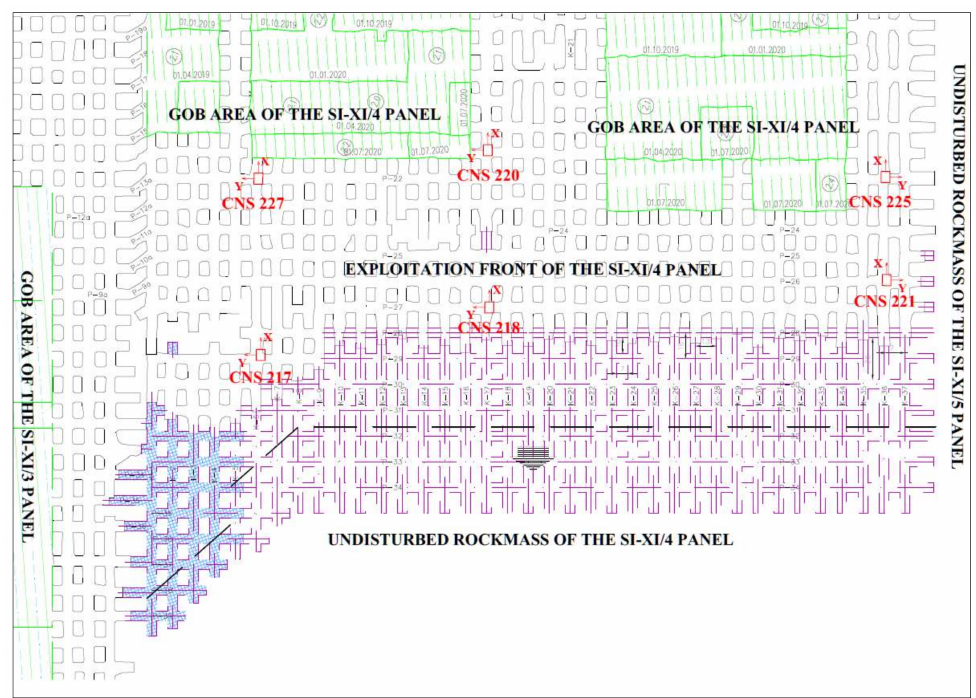
Figure 6. Location of measurement stations against the background of mining excavations at the start of the measurements.